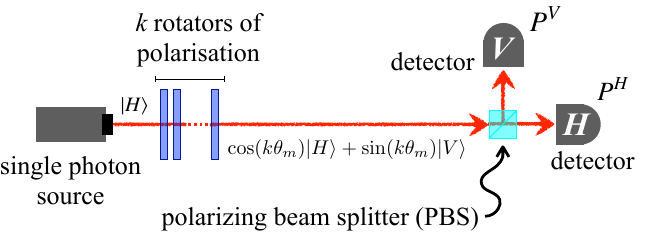
Figure 1. Scheme of the photonic implementation of the 1qfa highlighting the main involved optical elements. See the text for